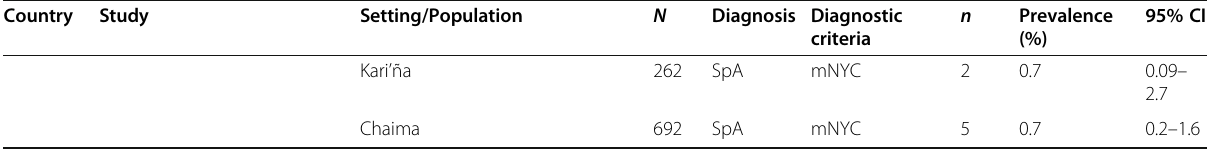
Table 1 Prevalence of SpA in Latin American countries (Continued)